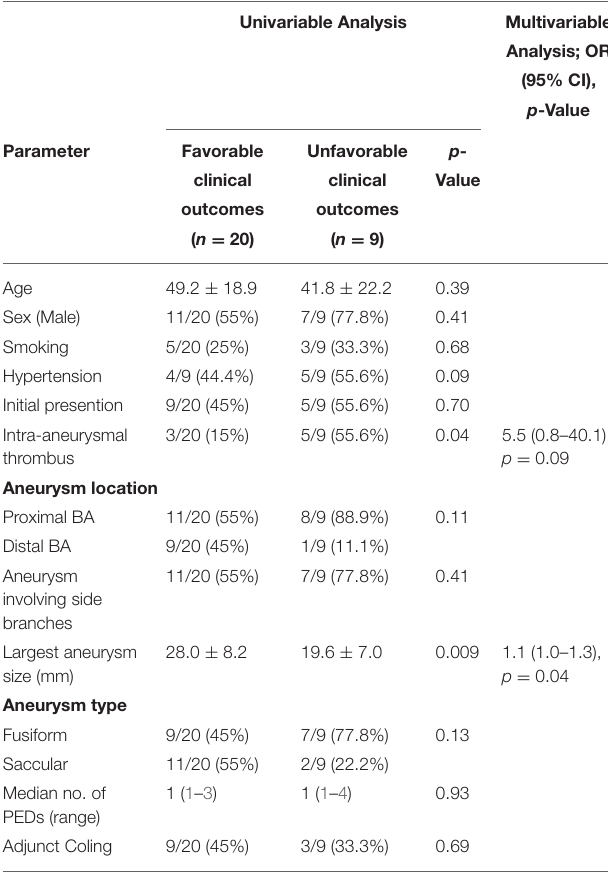
TABLE 2 | Univariable and multivariable analyses of factors associated with perioperative complications. Univariable Analysis